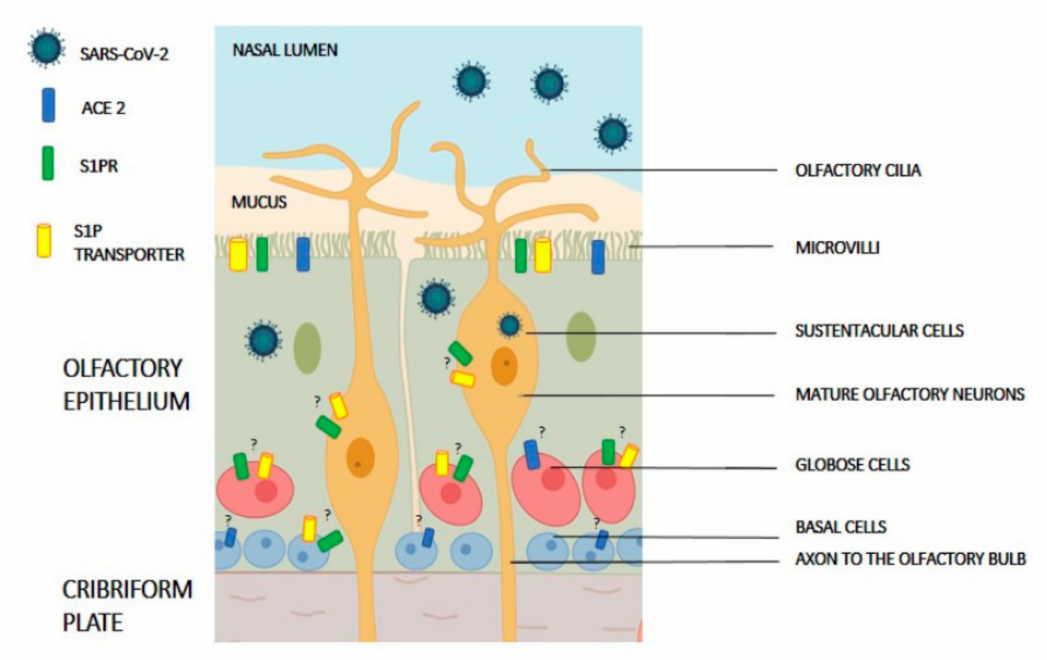
Figure 2. Schematic organization of olfactory epithelium. Known major cell types are shown: non-neuronal cells (progenitor and sustentacular cells) and olfactory neurons. The expression of angiotensin-converting enzyme 2 (ACE2) receptor, sphingosine 1-phosphate receptor (S1PR), S1P transporter (i.e., Spns2 orMfsd2b) and TMPRSS2 are shown in supporting cells as well as neuronal cells. Question marks indicate unknown expression in specific